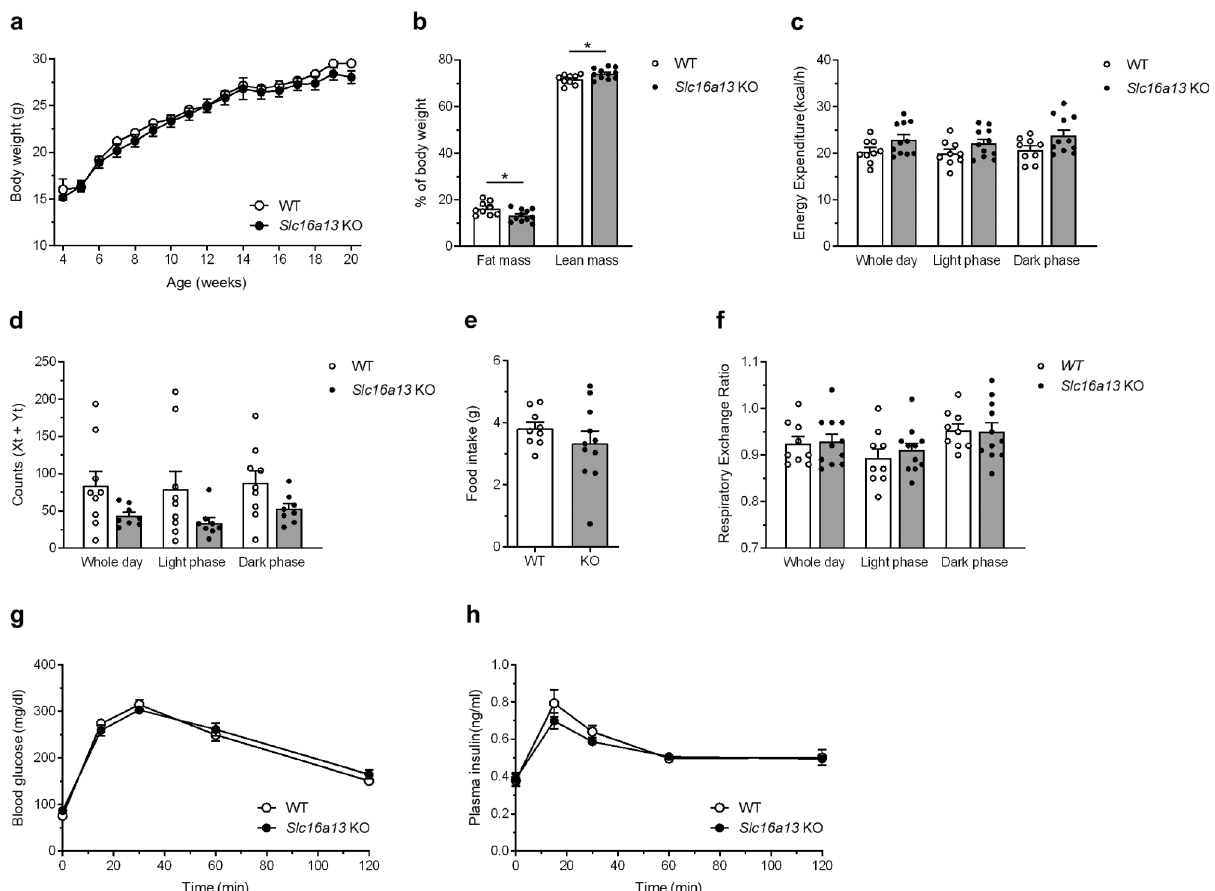
Fig. 4 Metabolic phenotype of NCD-fed Slc16a13 knockout mice. a Body weight of WT and Slc16a13 KO mice over a time course of 18 weeks. b – f Body composition, energy expenditure, locomotor activity, food intake, and respiratory exchange ratio (RER) of WT, and Slc16a13 KO mice at an age of 14 weeks. g , h Blood glucose levels and plasma insulin levels of WT and Slc16a13 KO mice after oral glucose administration at an age of 12 weeks. Slc16a13 WT ( n = 9), Slc16a13 KO ( n = 8 – 11). a , g , h Means ± SEM are displayed. b – f Bars represent means ± SEM. * p < 0.05 determined using two-tailed unpaired Student ’ s t